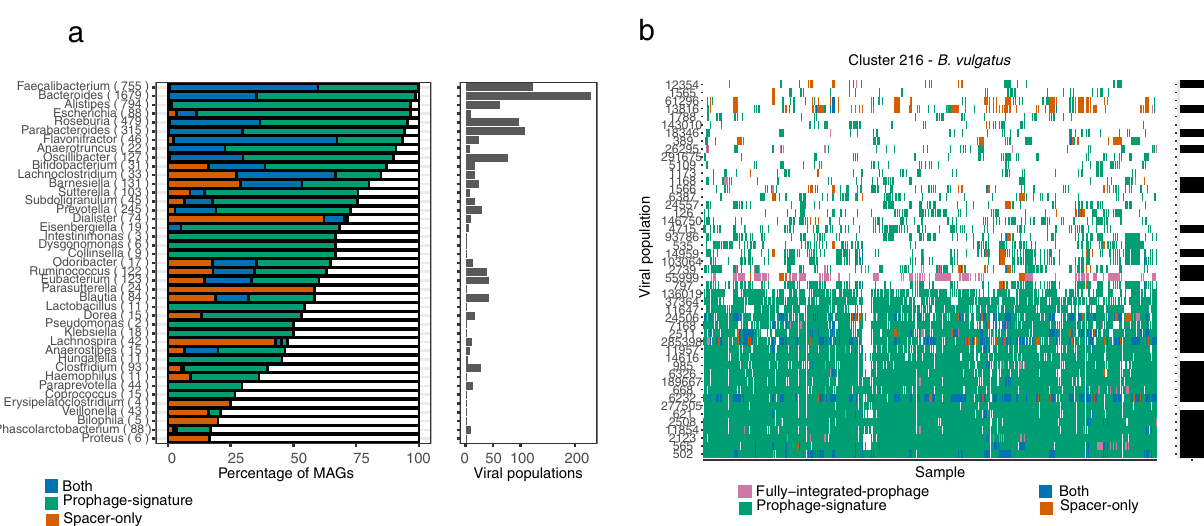
Fig. 5 Viral – host interactions can be explored from viral populations and MAGs. a Bacterial MAGs and viral relations. Each MAG was connected to the viral bins using either sequence alignment of the virus to MAG (green), CRISPR spacer alignment (orange) or both (blue). The right panel shows the percentage of MAGs, grouped by genera, that was annotated with the virus via alignment or CRISPR spacer. The number of distinct viral populations associated with a MAG genus based on either of the following: sequence alignment of the virus to a MAG within the given genera, CRISPR spacer alignment or both. b Viral association to all MAGs of VAMB cluster 216 ( B. vulgatus ) in the HMP2 dataset. For instance, viral population 502 was associated with the B. vulgatus across the vast majority of samples where B. vulgatus was